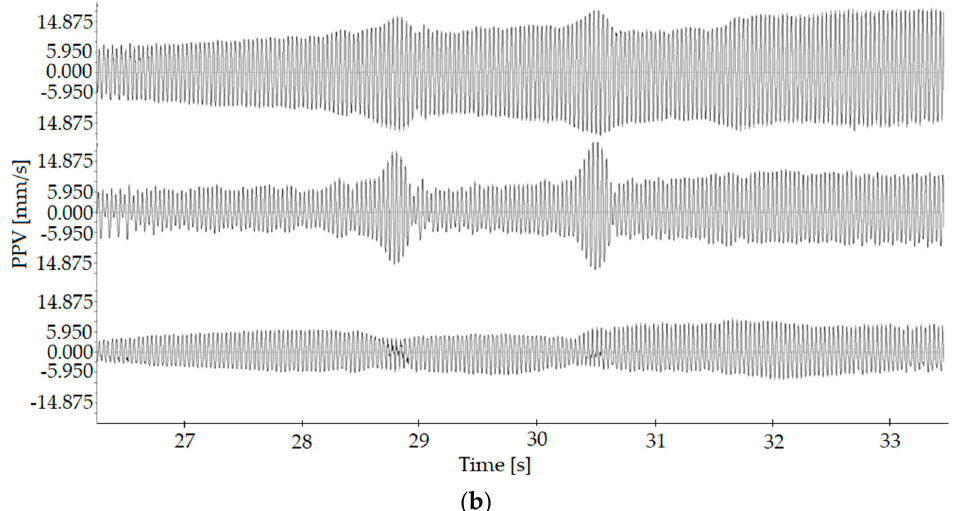
Figure 11. Examples of wave pattern records—( a ) first and ( b ) second stages of compaction.